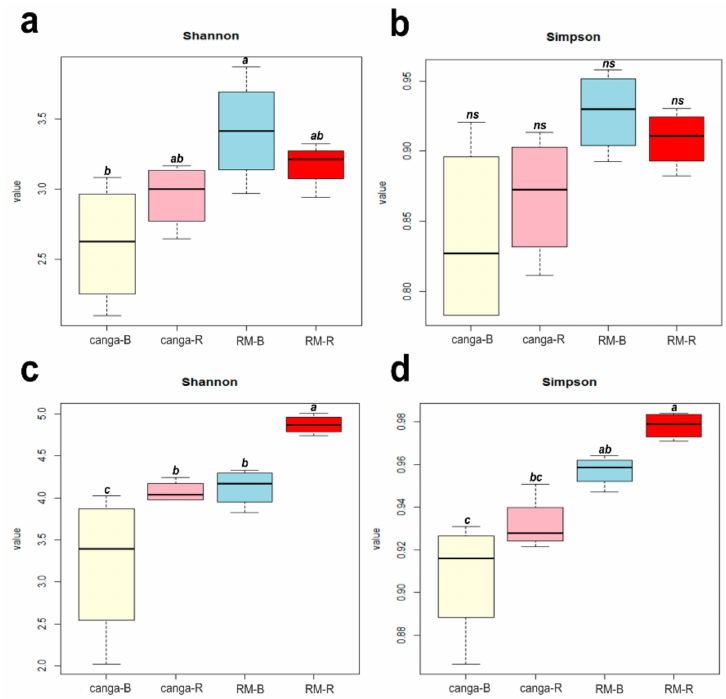
Figure 3. Alpha diversity (Shannon and Simpson) indices of sequences in rhizospheric and bulk substrates associated with D. apurensis growing in canga or rehabilitating minelands (RM). ( a , b ) Indices of fungal 18S rRNA. ( c , d ) Indices of bacterial 16S rRNA. canga_B and RM_B, bulk substrate; canga_R and RM_R, rhizospheric substrate. Different lowercase letters indicate statistical differences ( p > 0.05); ns = not